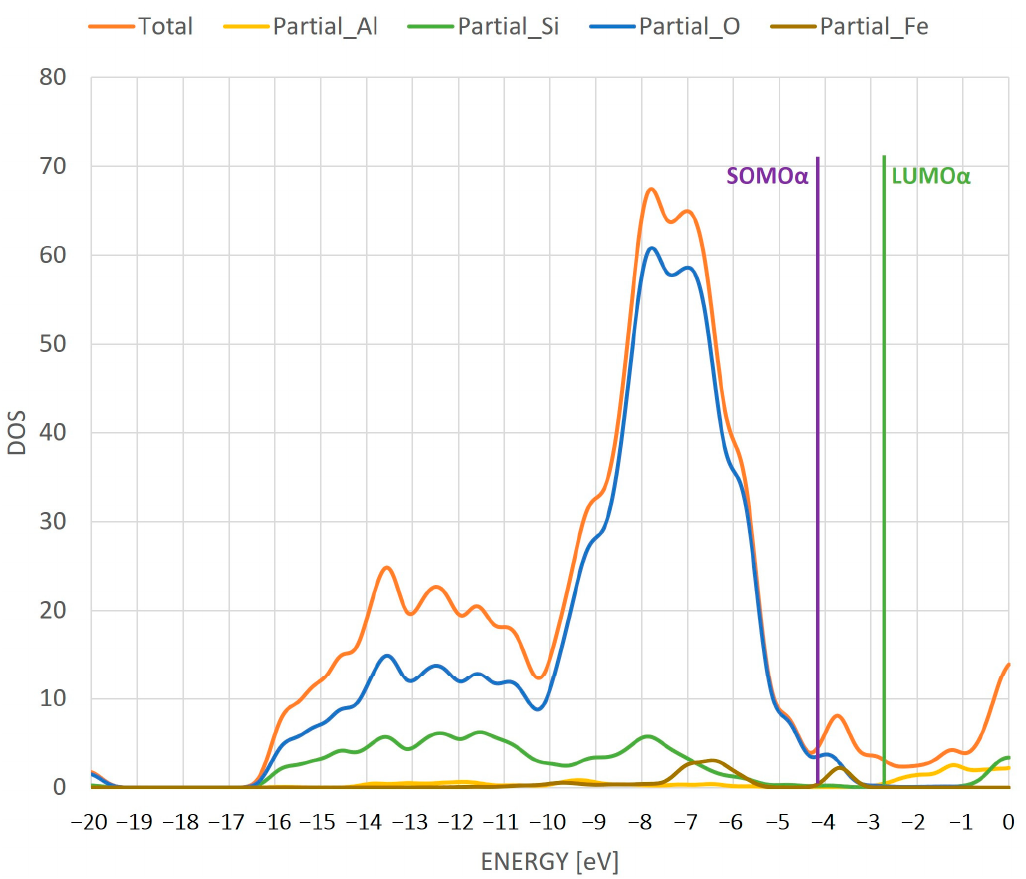
Figure 4. DOS diagram for individual atoms in the ZSM-5 structure with Fe adsorbed on the active site. The line in the diagram shows the position of SOMO and LUMO orbitals.